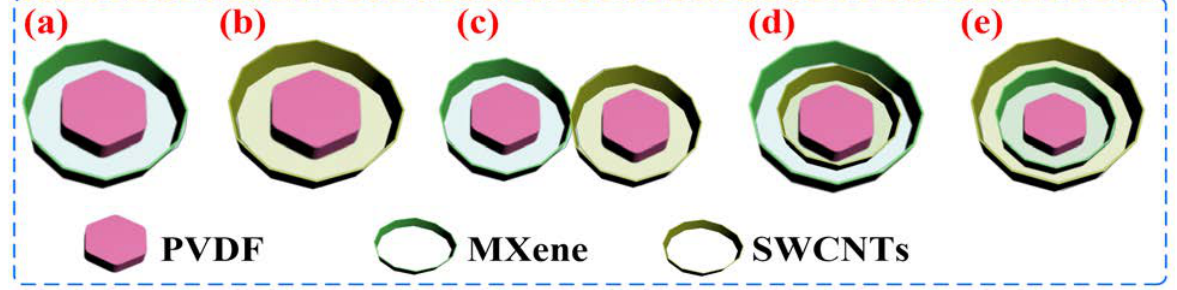
Figure 1. Schematic illustration of structure unit in ( a ) PVDF/MXene5, ( b )PVDF/SWCNTs2, ( c ) PVDF/MXene/SWCNTs, ( d ) PVDF-SWCNTs-MXene, and ( e ) PVDF-MXene-SWCNTs composite. The preparation of PVDF/MXene5, PVDF/SWCNTs2, PVDF/MXene/SWCNTs,